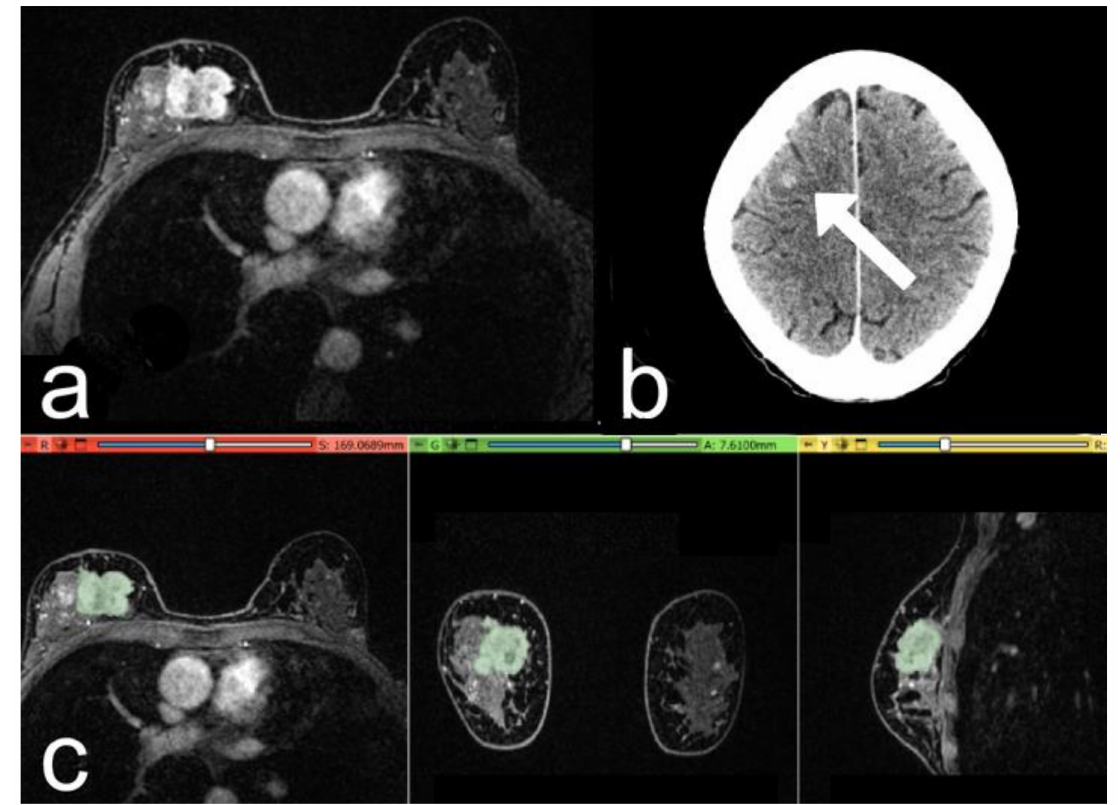
Figure 4. Case of a 53-year-old woman with a G2 Luminal B invasive ductal carcinoma, Ki-67 of 25%. ( a ) The post-contrast image shows an irregular mass-enhancing lesion in the upper quadrants of the right breast. ( b ) At 3-year follow-up: post-contrast axial CT image, with a metastatic nodule in the right frontal lobe (arrow). ( c ) Representation of the extraction of the segmentation